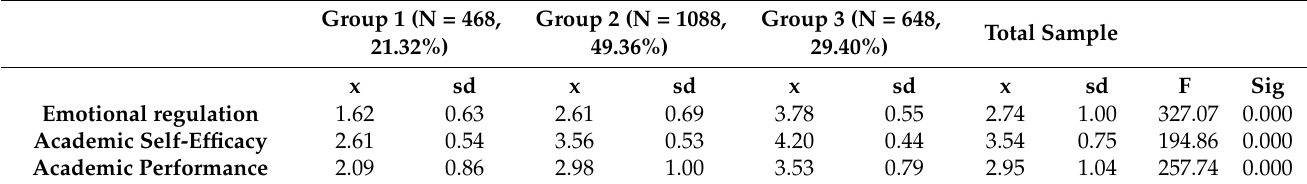
Table 4. Cluster analysis between emotional regulation, self-efficacy and academic performance.